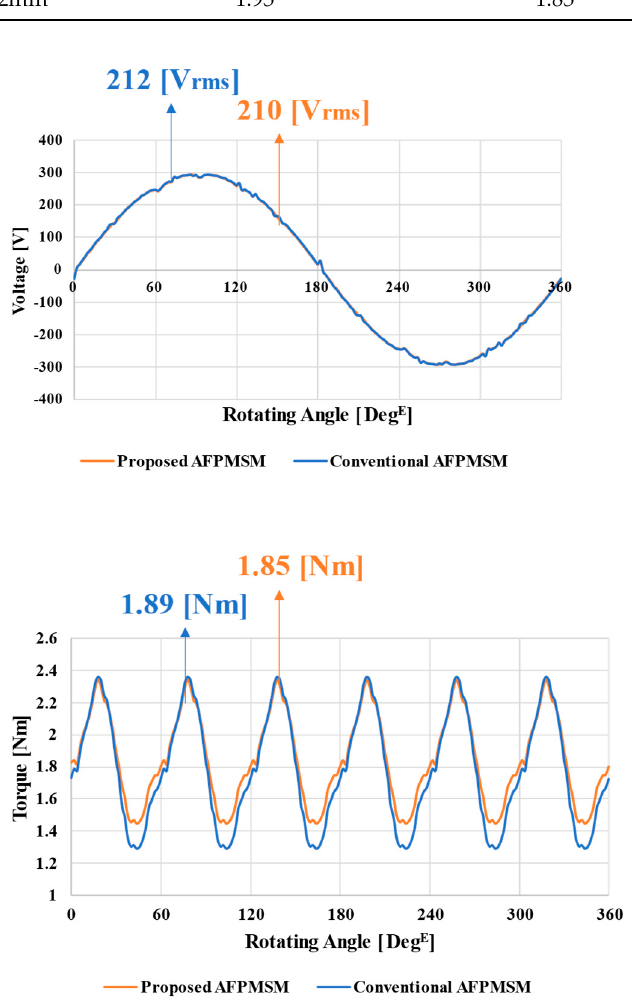
Figure 8. Performance comparison between the final proposed model and the conventional AFPMSM model.